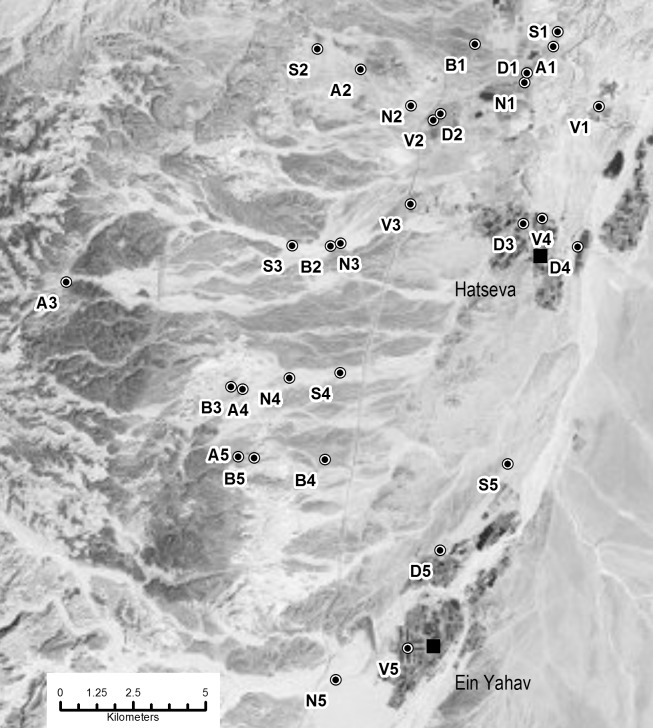
Satellite map of sites.A is dense acacia stands, S is sparse acacia stands, B is barren acacia stands, N is non-acacia desert sites, V is village sites and D is date plantations. The five replicates of each habitat type are numbered one to five from north to south (Reprinted with permission from Esri, original copyright 2012).